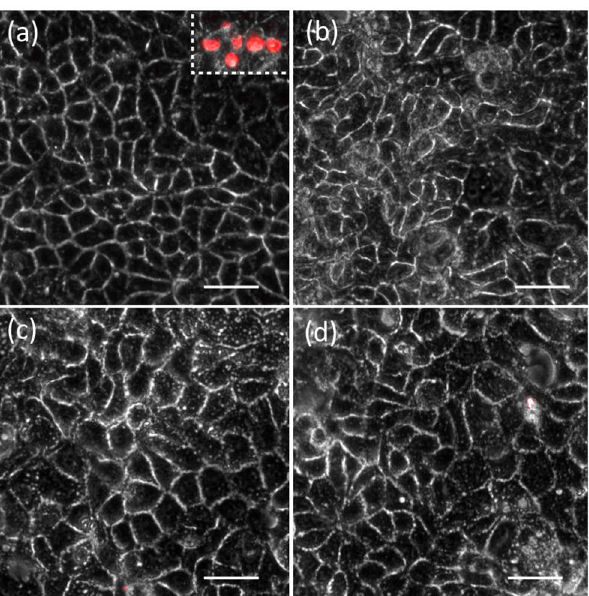
Fig 6. Live-dead analysis indicates that E171 is not immediately cytotoxic to Caco-2 epithelia. (a) UntreatedCaco-2 display the traditionalhoneycombarrangement of cells within the epithelium.Note the existence of no ethidium-positive (red) cells. The inset is a positive control for cell death. Red cells indicate cell death. (b) Exposure to 1 μ g/mL of E171 (total fraction) after 24 hours. (c) Exposure to 1 μ g/mL of submicron-enriched E171 after 24 hours. (d) Exposure to 1 μ g/mL of submicron-enrichedE171 after 24 hours. The scale bars are 20 μ